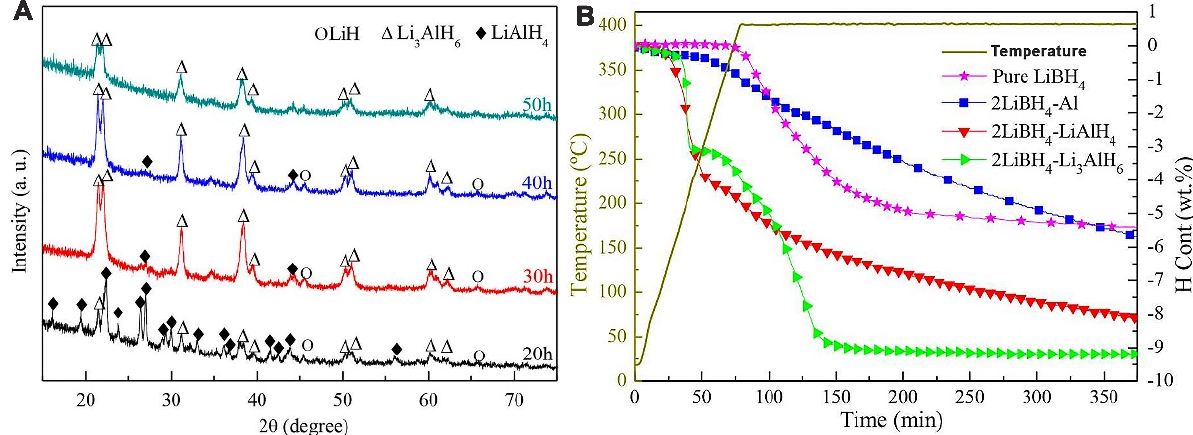
Figure 3. ( A ) XRD patterns of mixed powder of LiH and LiAlH 4 after ball-milling for different num- bers of hours; ( B ) TPD curves of pure LiBH 4 , 2LiBH 4 –Al, 2LiBH 4 –LiAlH 4 and 2LiBH 4 –Li 3 AlH 6 sam- ples. Reprinted from ref. [122], Copyright © 2020 Li, Wu, Zhu, He, Xiao and Chen, distributed under the terms of the Creative Commons Attribution License (CC